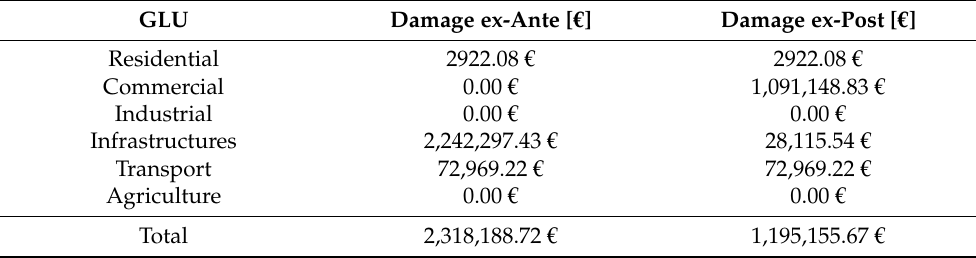
Table 9. Damage comparison ex-ante and ex-post NBS application by GLU.